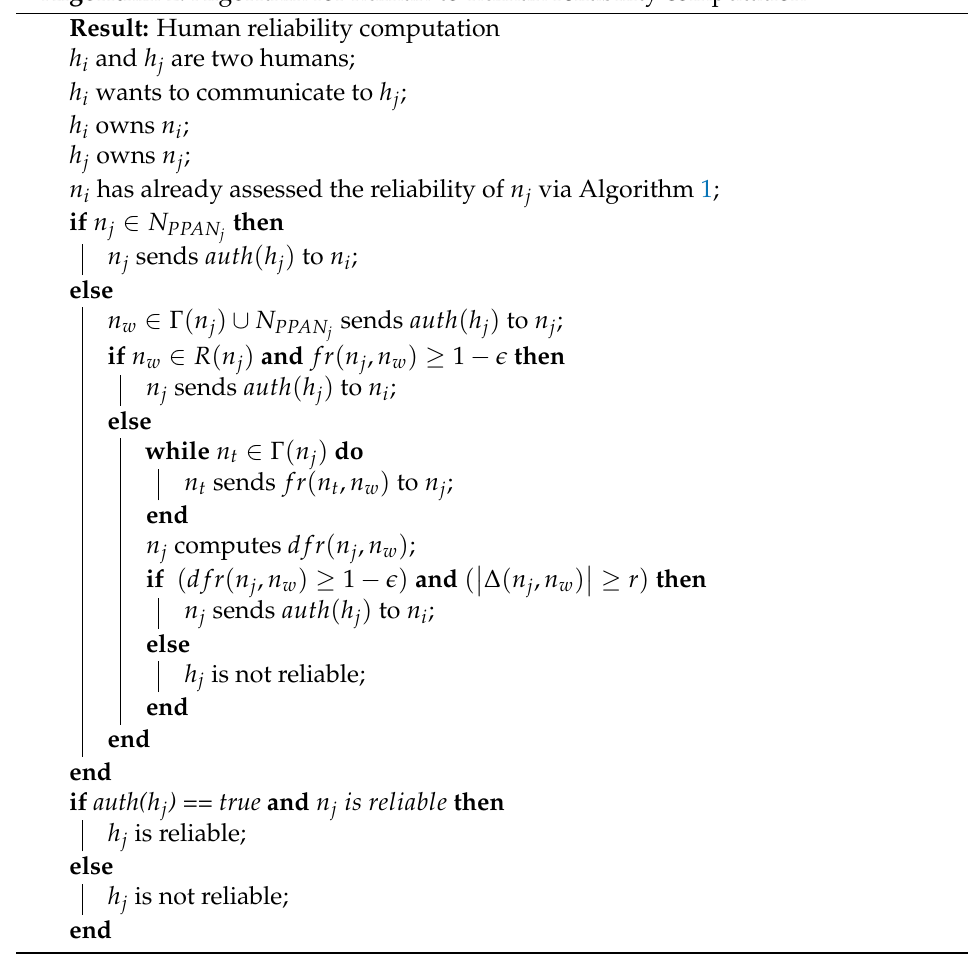
Algorithm 2: Algorithm for human-to-human reliability computation Result: Human reliability